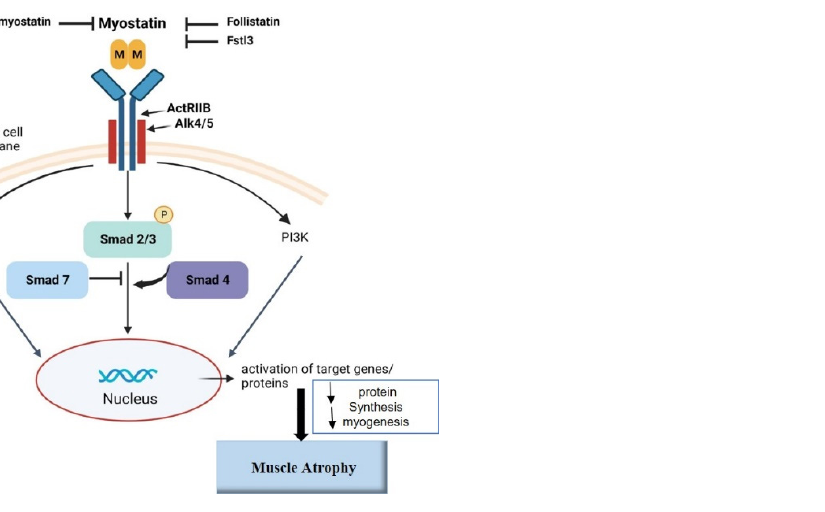
Figure 6. Myostatin signaling pathway. Myostatin is secreted as a propeptide and cleaved by proteases to mature myostatin. The active myostatin dimer binds to ActRIIB leading to phosphorylation and dimerization of ALK4 and/or ALK5. Among others, the Smad pathway is activated which involves the phosphorylation of Smad 2/3 forming a complex with Smad 4. This complex translocates to the nucleus and activates or inhibits target genes [10,15].